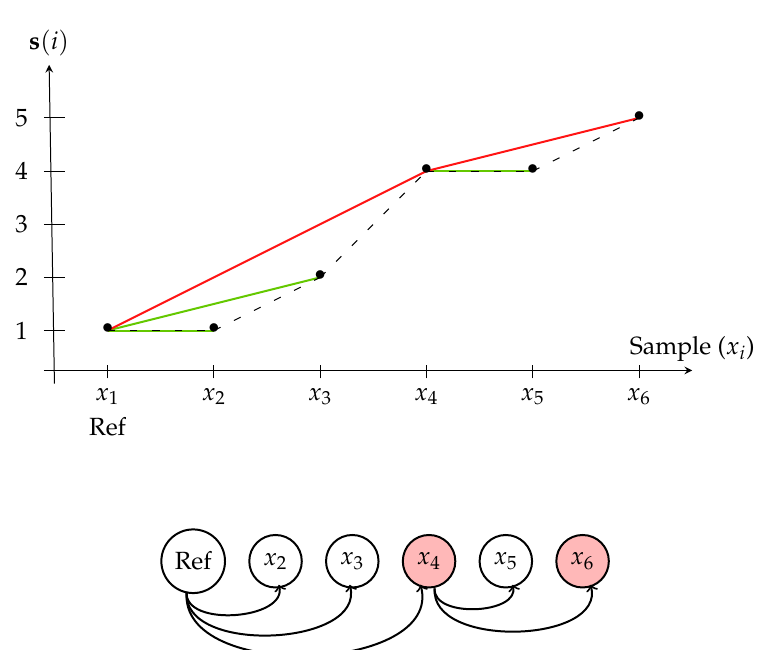
Figure 8. Example of scores that are increasing (dashed line) in an absolute detection test describing no detection of a stimulus (in green) and the detection of a first stimulus (in red) at sample x 4 when compared to the reference sample x 1 and a second stimulus (in red) at sample x 6 when compared to the new reference sample x 4 and where a threshold (cid:101) = 1 is